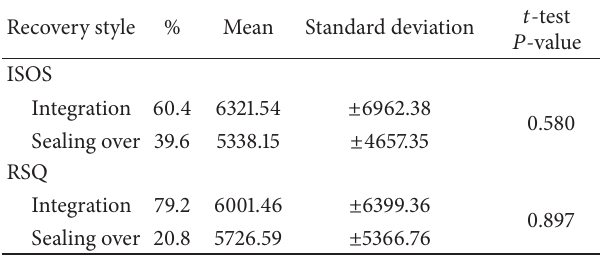
Table 1: Frequency of recovery style patterns according to ISOR/RSQ results and 𝑡 -test for annual cost per patient between different groups of recovery